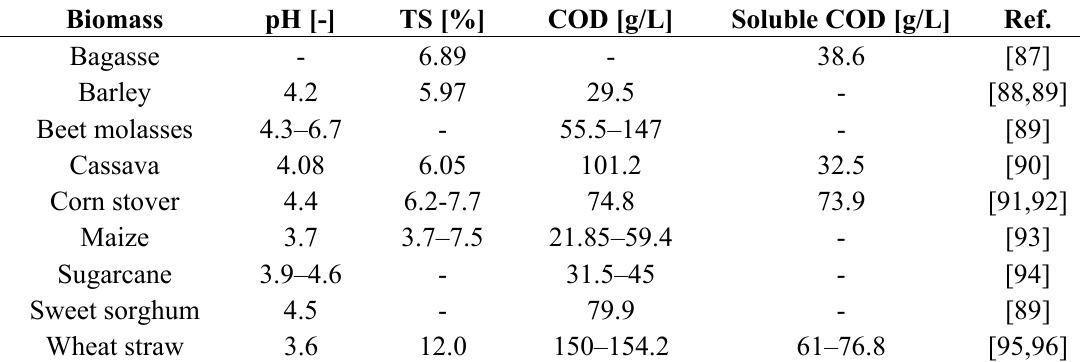
Table 3. Characteristics of stillage from the fermentation of different biomasses.